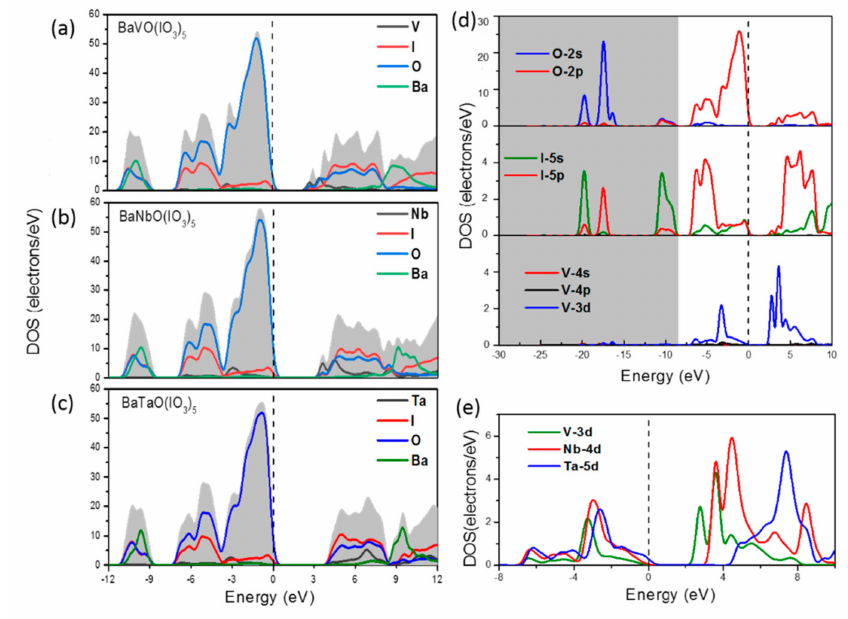
Figure 6. PDOS projected to the constituent atoms of ( a ) BaVO(IO 3 ) 5 ; ( b ) BaNbO(IO 3 ) 5 ; ( c ) BaTaO(IO 3 ) 5 ; ( d ) PDOS of the O-, I-, and V-orbitals in BaVO(IO 3 ) 5 ; and ( e ) PDOS of the M-d